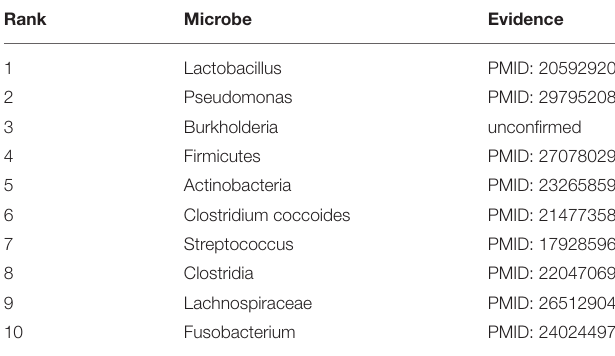
TABLE 1 | Prediction list of the top 10 potential asthma-related microbes based on the known associations in HMDAD database and the corresponding validation evidences (experimental literatures in PubMed) for these